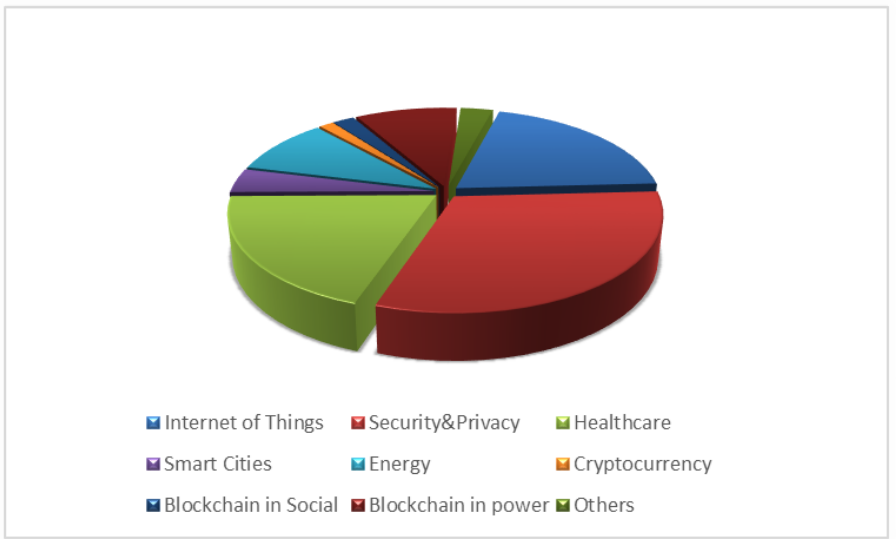
Figure 7. Blockchain Application